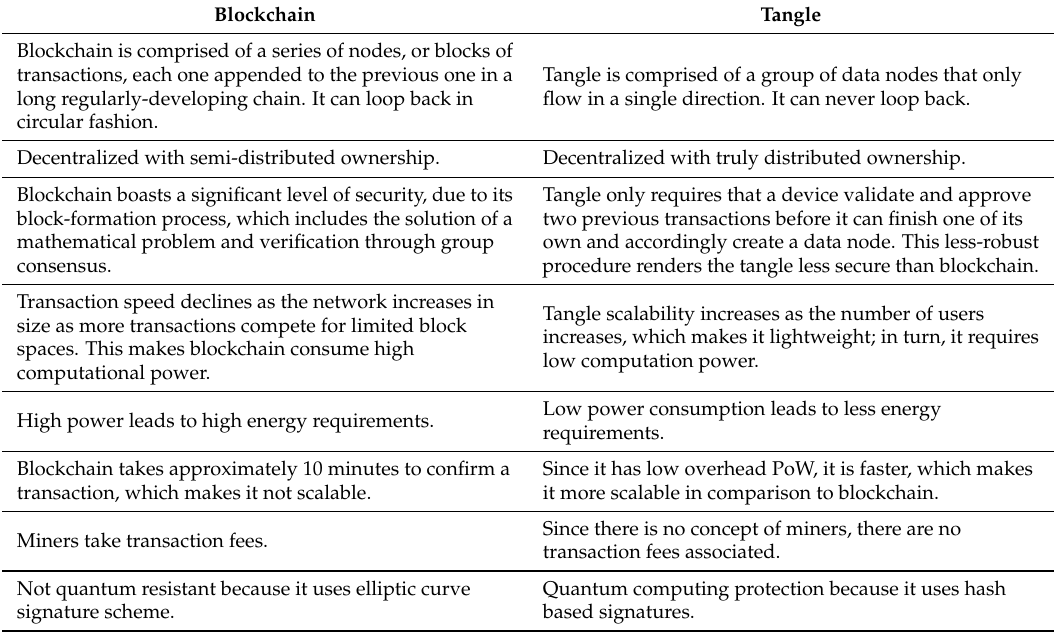
Table 6. Blockchain and Tangle